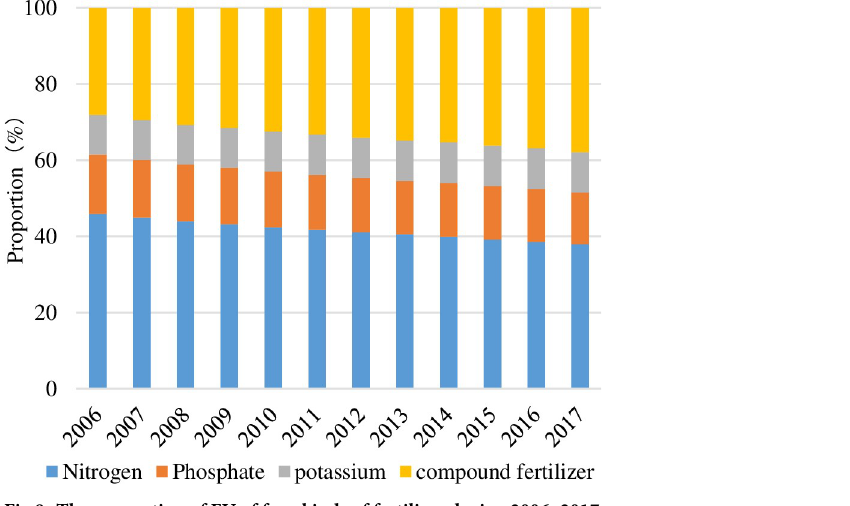
Fig 8. The proportion of FU of four kinds of fertilizer during